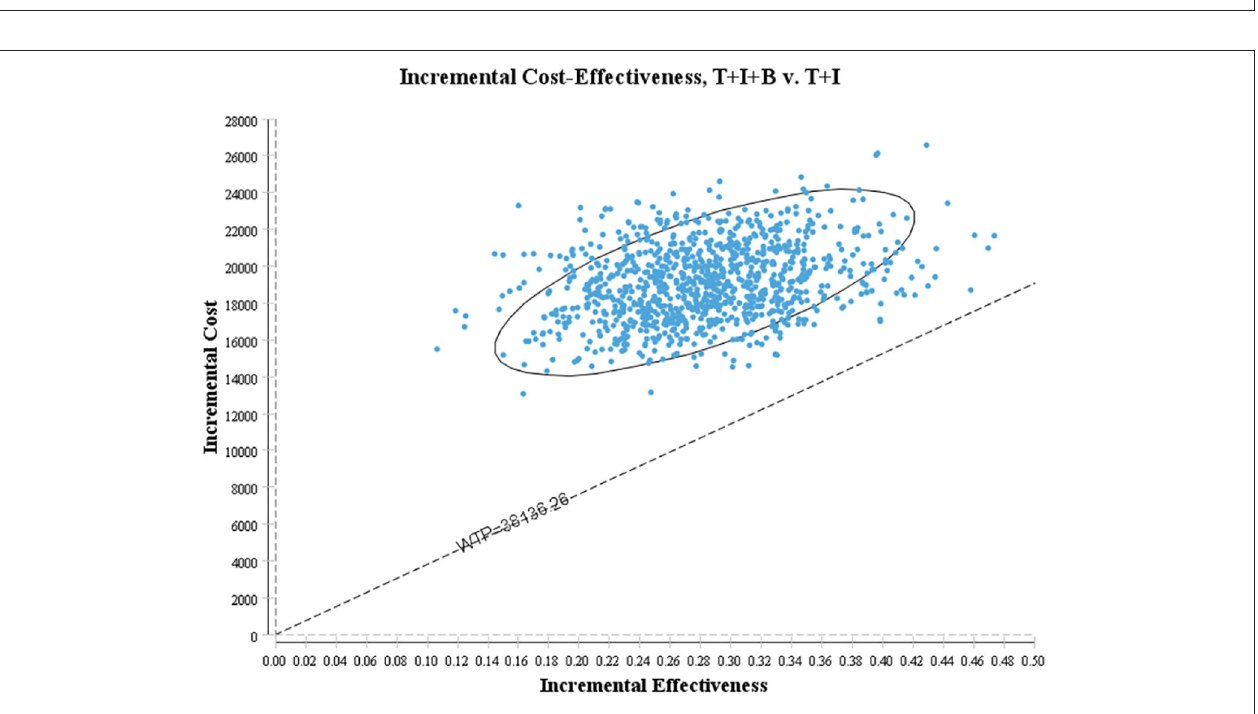
FIGURE 4 | Scatter plot of probabilistic sensitivity